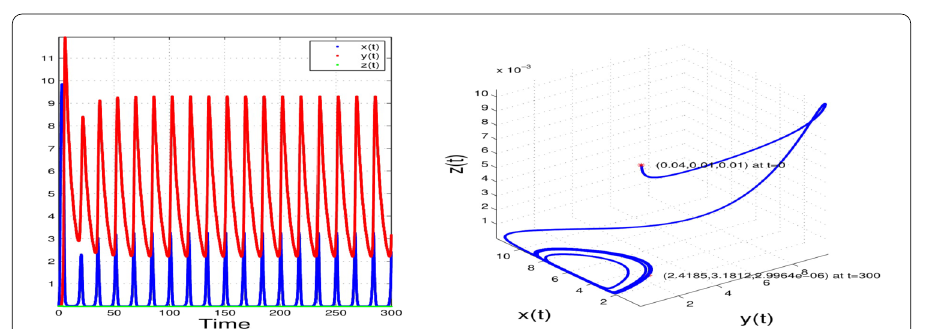
Figure 6 The local stability of the equilibrium (cid:7) 2 =